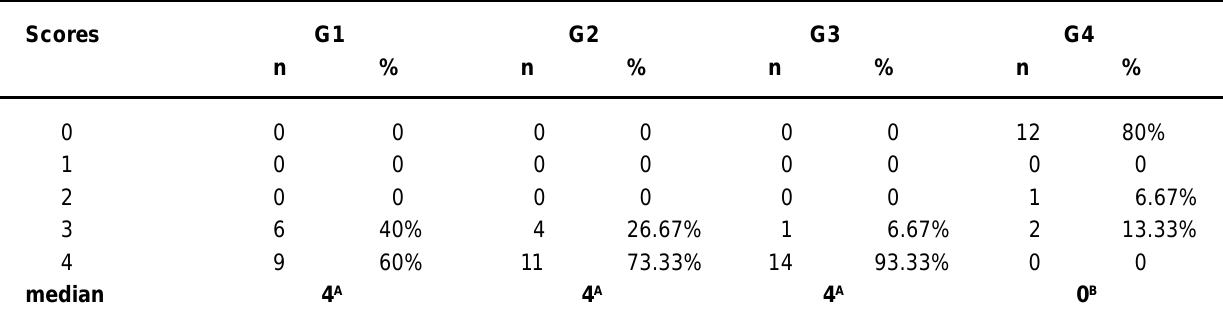
TABLE 2- Distribution of absolute (n) and relative (%) frequency and median of scores (Vita shade guide) obtained in experimental groups 14 days post-bleaching